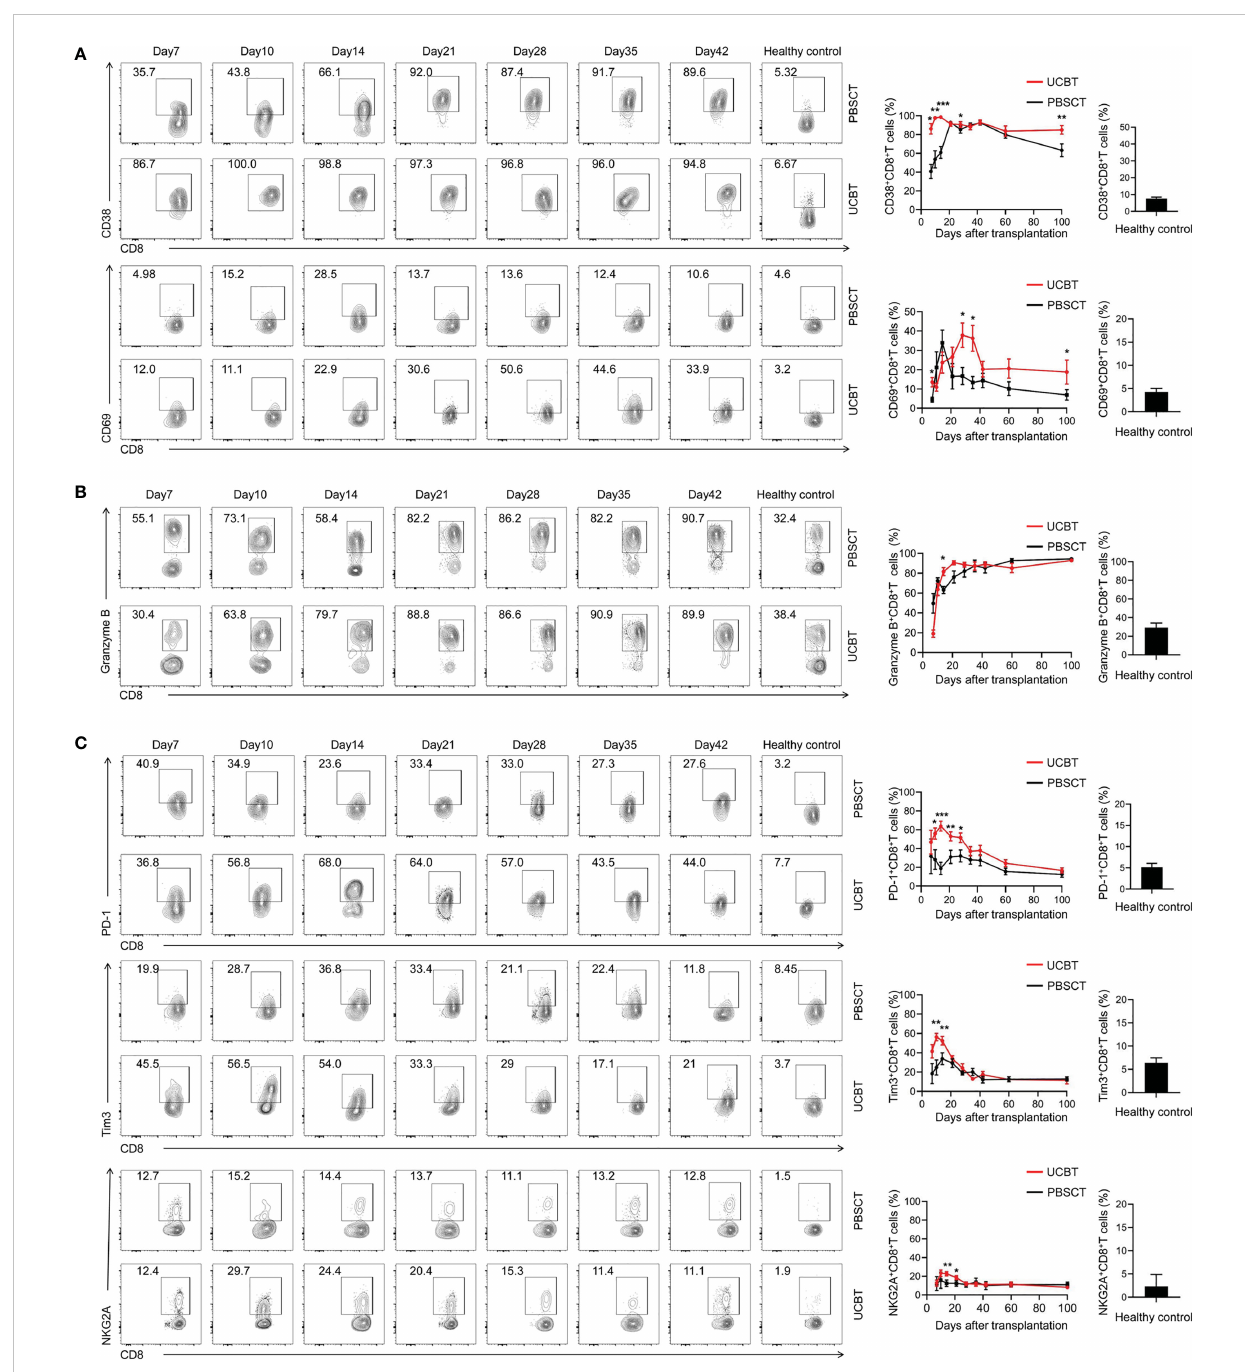
FIGURE 5 The dynamic changes of functional molecules expression levels in the CD8 + T cell subpopulations with UCBT and PBSCT. Representative fl ow cytometry contour plots and the dynamic changes in the expression levels of (A) CD38, CD69, (B) GZMB, (C) PD-1, Tim3 and NKG2A in the gated CD8 + T cells during the early posttransplant period after UCBT and PBSCT. The histogram shows data for the healthy control group. CM, central memory; EM, effector memory; TEMRA, terminally differentiated effector memory. The data were analyzed by the Mann – Whitney U test and represented as means ± SEM. * p <0.05; ** p <0.01; *** p